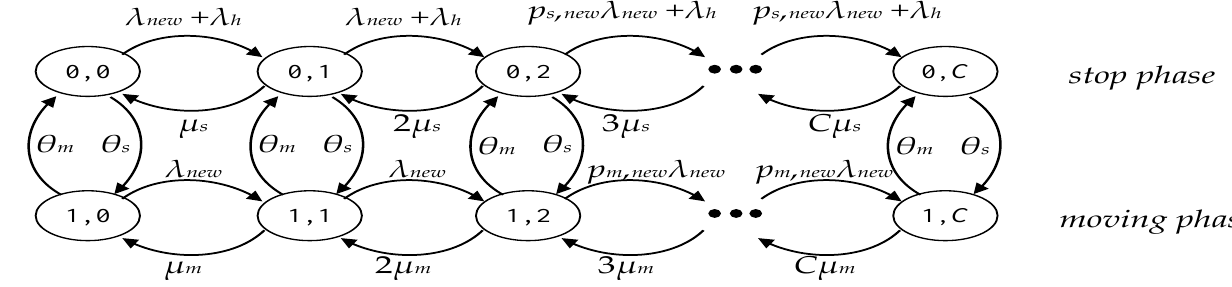
Figure 2. The 2-D state transition diagram in the proposed generalized probabilistic BR loss model.